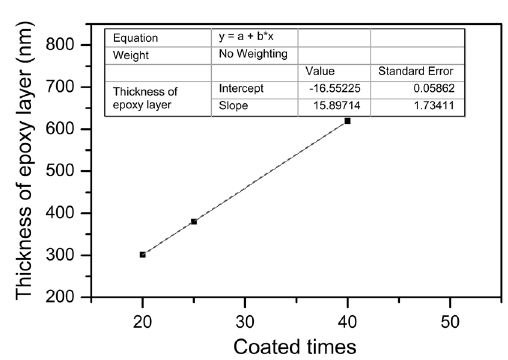
Figure 2: Relationship between the thicknesses of the epoxy resin and the number of coatings Figure 2 shows that the thickness of the epoxy resin coated onto the ferrosilicon surface increases linearly with increasing coating times. Specifically, the mean thickness of the epoxy resin film increases 15 nm with each coating.